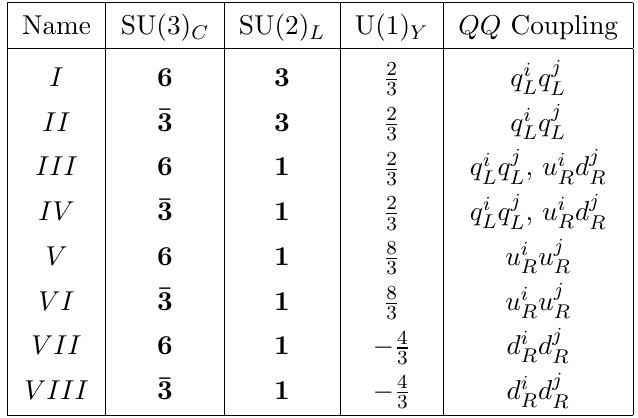
Table 10 . Scalar diquarks: quantum numbers and